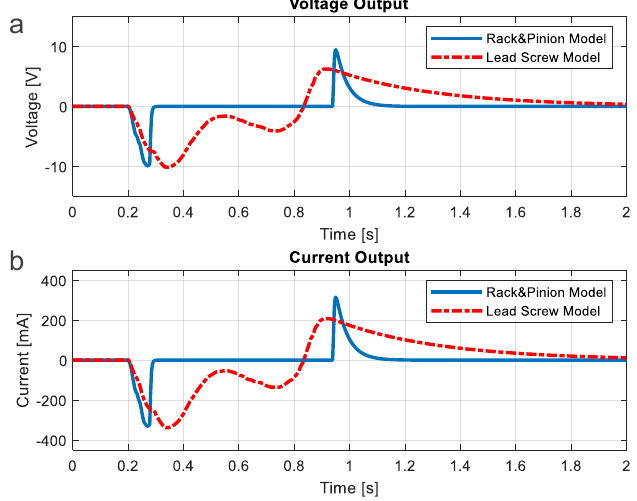
Figure 10. Simulation of Rack-Pinion and Lead-Screw Model. ( a ) Voltage of Rack-Pinion and Lead-Screw Model. ( b ) Current of Rack-Pinion and Lead-Screw Model.